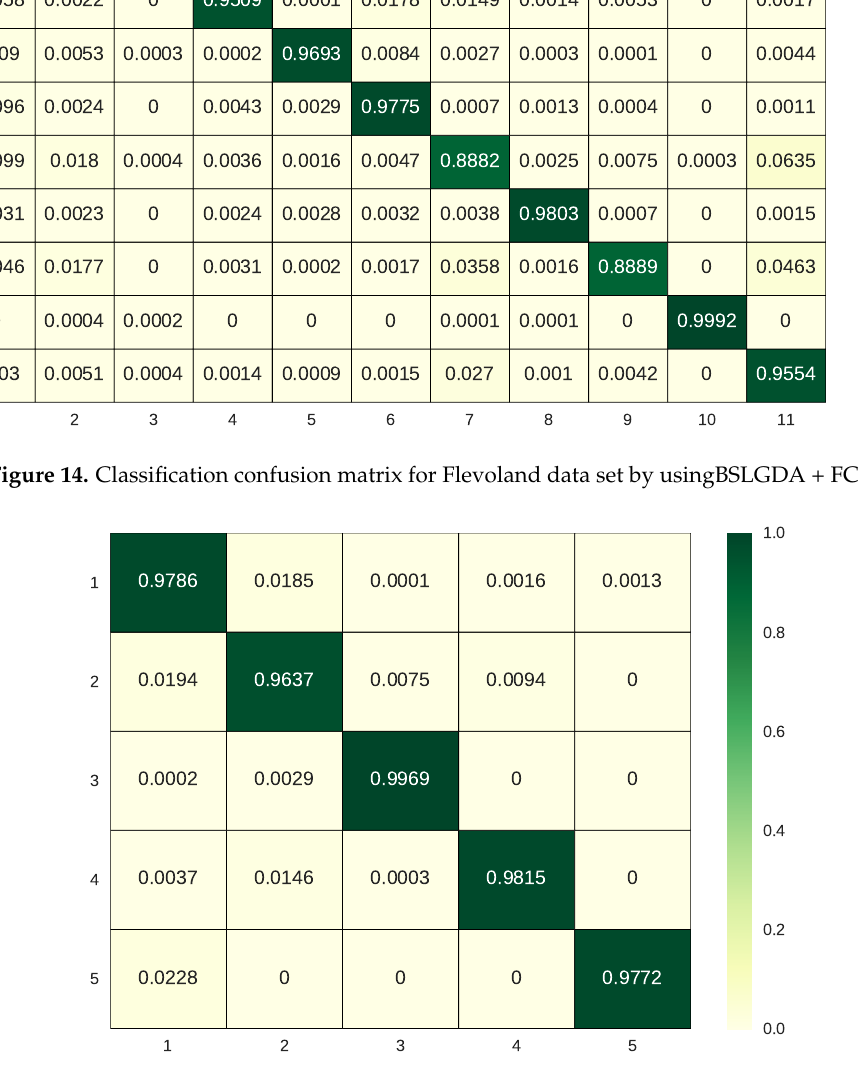
Figure 15. Classification confusion matrix for San Francisco data set by using BSLGDA +